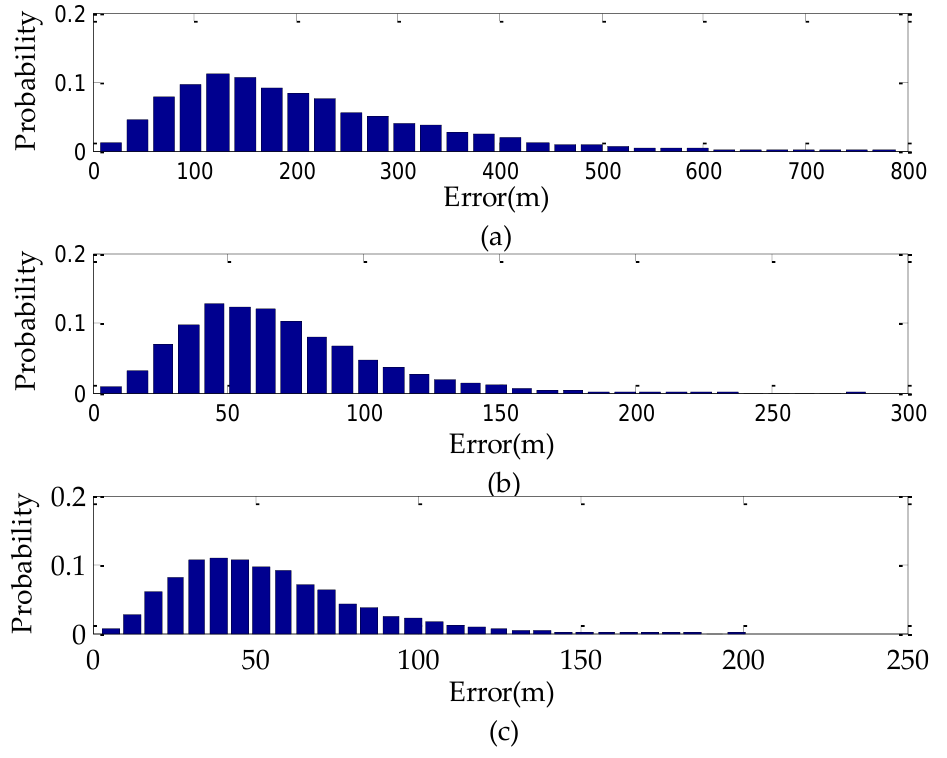
Figure 4. Probability of geo-location error by the traditional method: ( a ) The off-nadir looking angle is 75°; ( b ) The off-nadir looking angle is 35°; ( c ) The off-nadir looking angle is 0°.